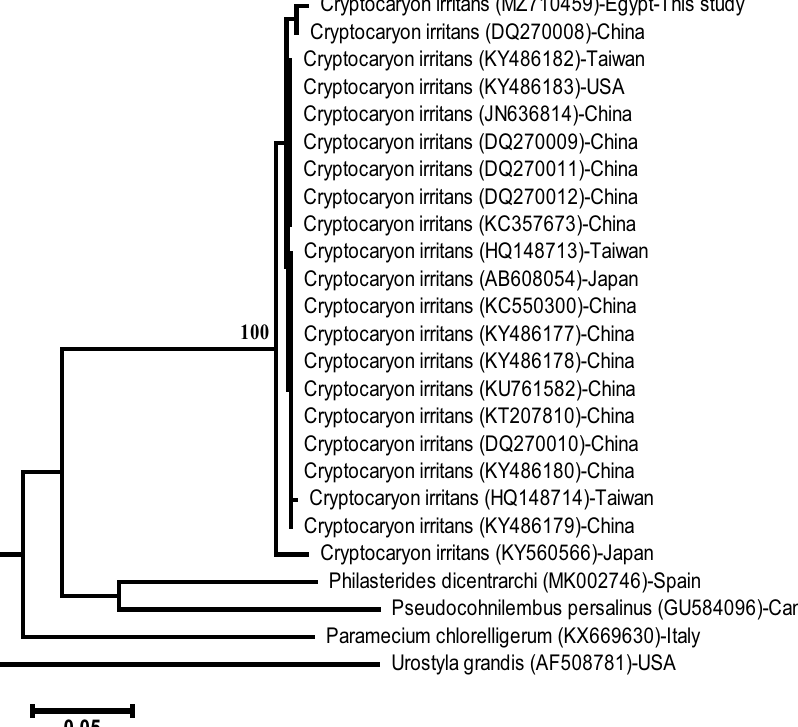
Cumulative mortality (%)Skin